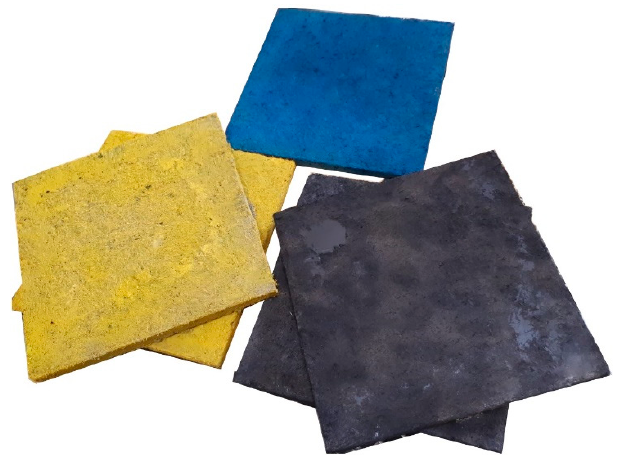
Figure 18. Colorful acoustic panels for assembling on internal walls.